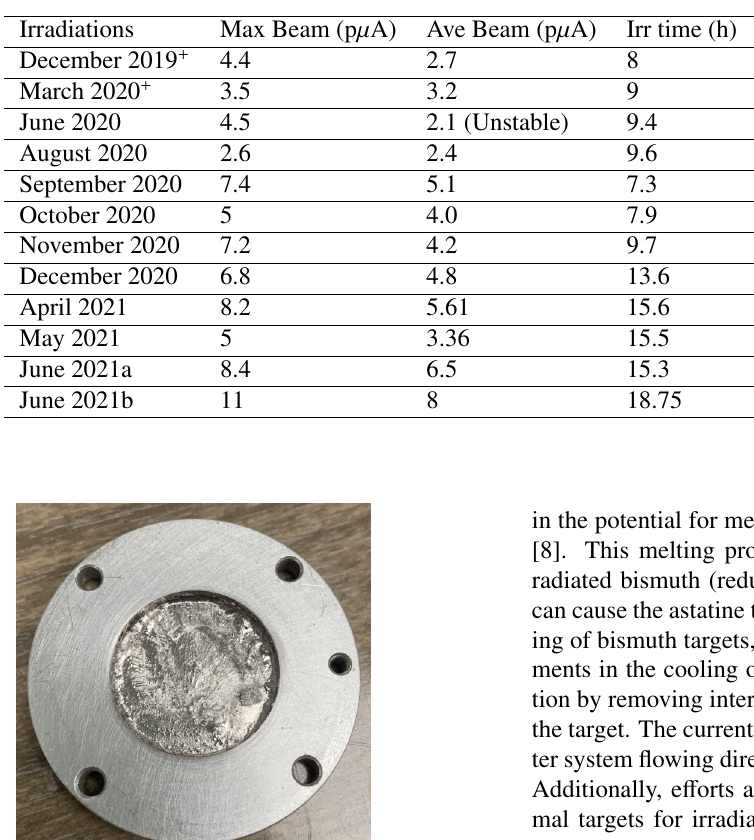
Table 1. At-211 production. The plus signs denote irradiations done using the 2 + charge state of the alpha beam, activities were calculated using a di ff erent method for the asterisks (*).